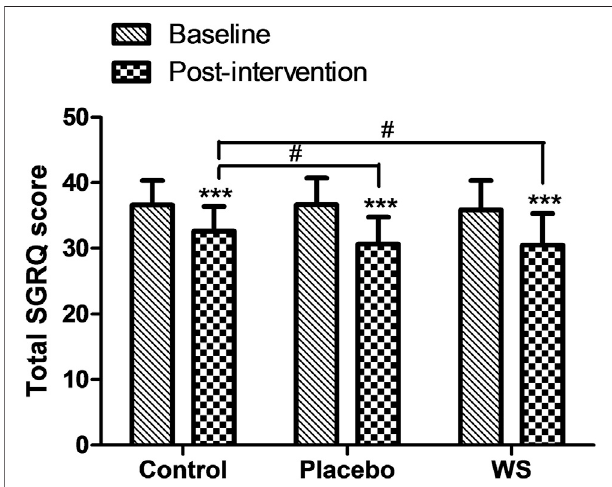
FIGURE 3 | Effect of interventions on the quality of life of patients: Mean SGRQ total score at the baseline and at the end of the study. *** p ≤ 0.001 compared with baseline. # p ≤ 0.05.